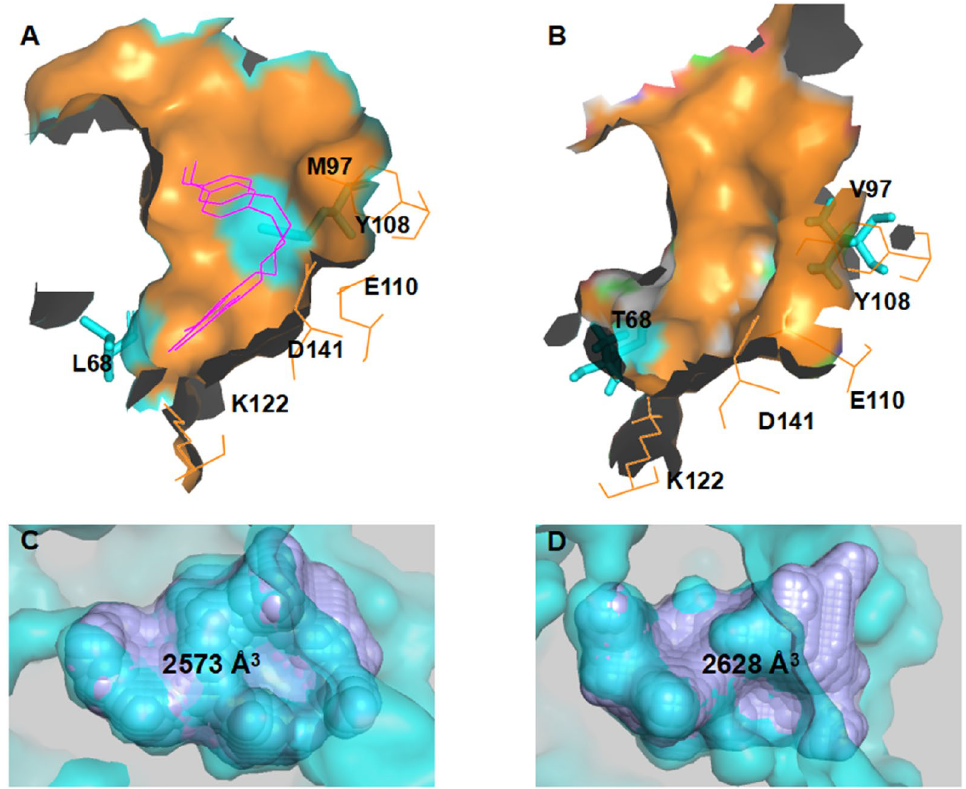
Fig. 8 Structural analysis of the substrate‑binding pocket of Tf NCS and its mutant L68T/M97V using POCASA 1.1. A Sectional view of the substrate pocket in Tf NCS. B Sectional view of the substrate pocket in mutant L68T/M97V modelled by AlphaFold2. C Volume of the substrate‑binding pocket in the WT enzyme. D Volume of the substrate‑binding pocket in mutant L68T/M97V